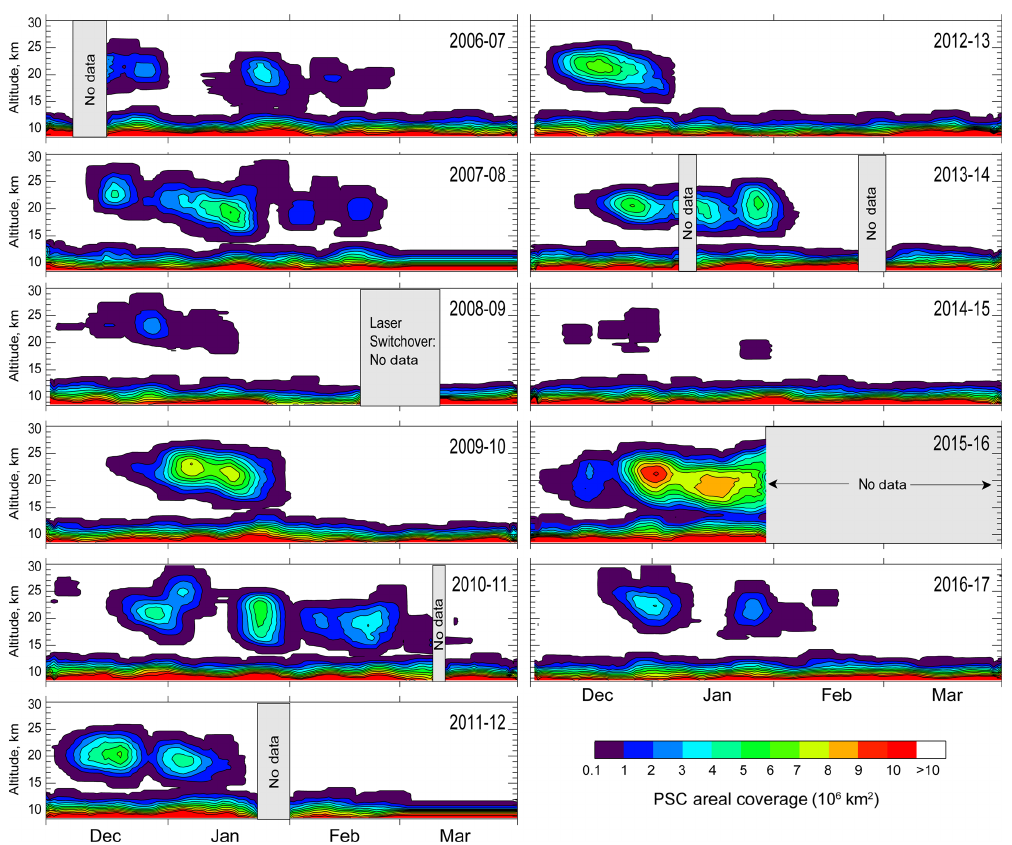
Figure 20. Daily PSC areal coverage as a function of altitude for each of the 11 Arctic winters in the CALIOP v2 data record. Note the change in color scale compared with Fig. 13.